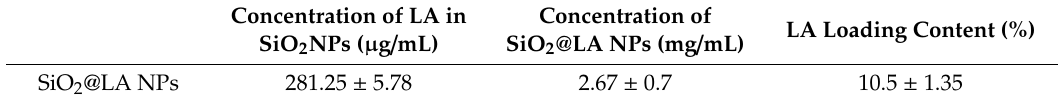
Table 1. Concentration value of lauric acid (LA) in SiO 2 NPs expressed in µ g / mL (obtained with HPLC analysis) and concentration of SiO 2 @LA NPs expressed in mg / mL. The resulting LA loading content expressed in (%) was obtain applying the equation: amount of LA in SiO 2 NPs / Amount of SiO 2 @LA